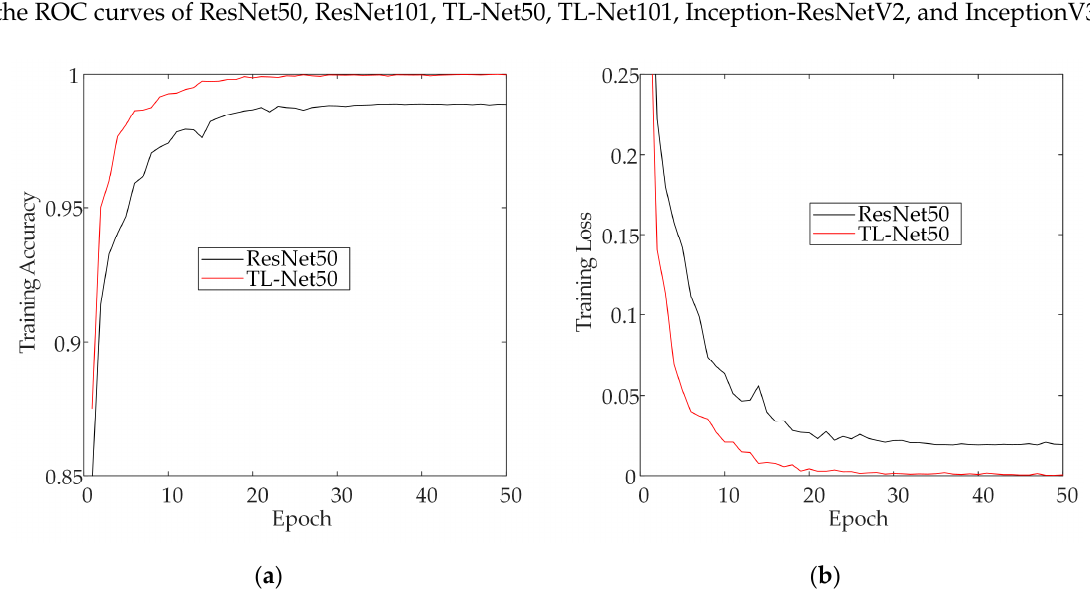
Figure 10. The ROC curves of ResNet101, OIM-ResNet101, OSEM-ResNet101, and TL-Net101.